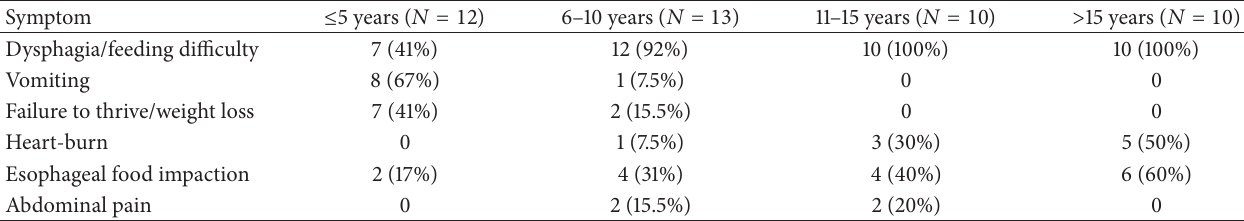
Table 2: Symptoms of eosinophilic esophagitis based on age at presentation.